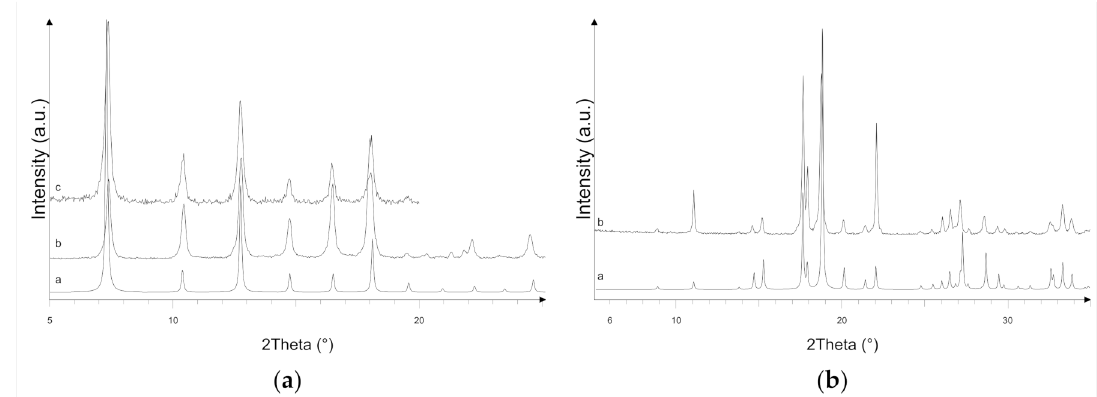
Figure 1. X-ray powder diffraction (XRPD) of ( a ) zeolitic imidazolate framework-8 (ZIF-8) and ( b ) Zn(II) and benzene-1,3,5- tri-carboxylate (Zn 3 (BTC) 2 ): simulated (pattern a), as prepared (pattern b), and activated (pattern c). a.u. = arbitrary